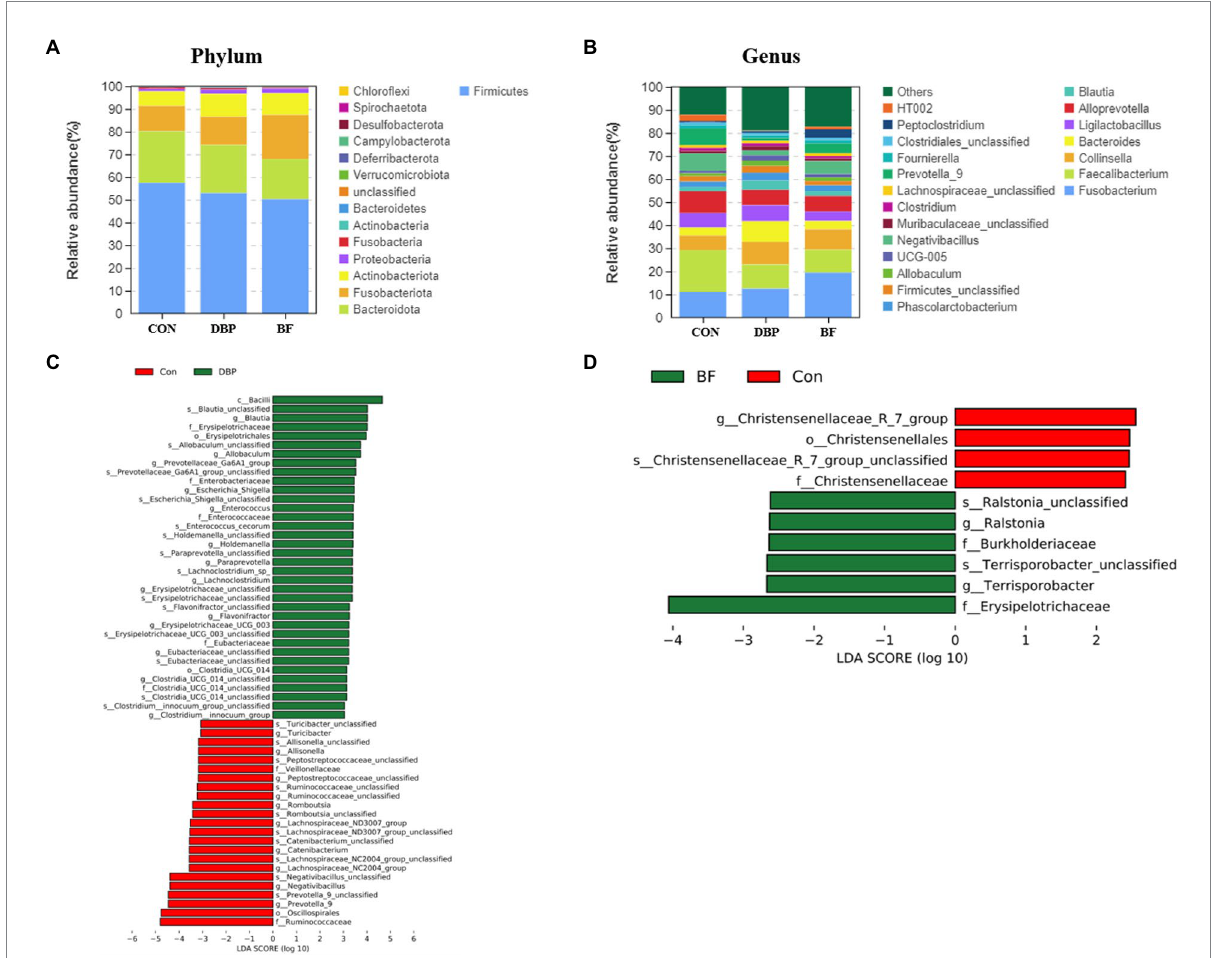
FIGURE 2 Effects of DBP and BF on gut microbiota and structure in dogs. Histogram of abundance distribution at phylum (A) , and genus (B) . The LEfSe analysis between the CON group and the DBP (C) , or the BF groups (D)